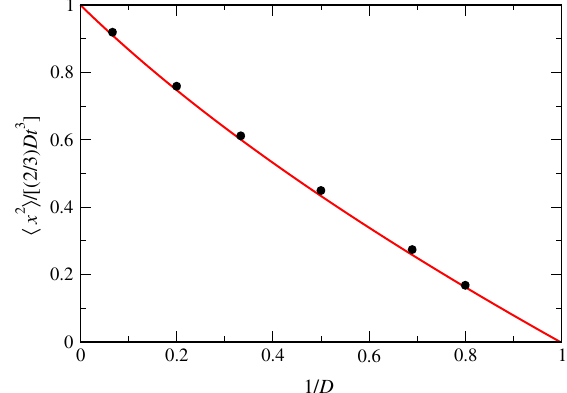
FIG. 10. Scaled mean-square displacement (filled circles) for the Richardson-Obukhov phase. Simulations and theory (solid line) nicely match without fitting. Close to the transition to the Lévy phase, i.e., D → 1 , the finite time simulations slowly converge to the asymptotic limit, as might be expected. In the simulations, we used t ¼ 10 5 and averaged over 10 5